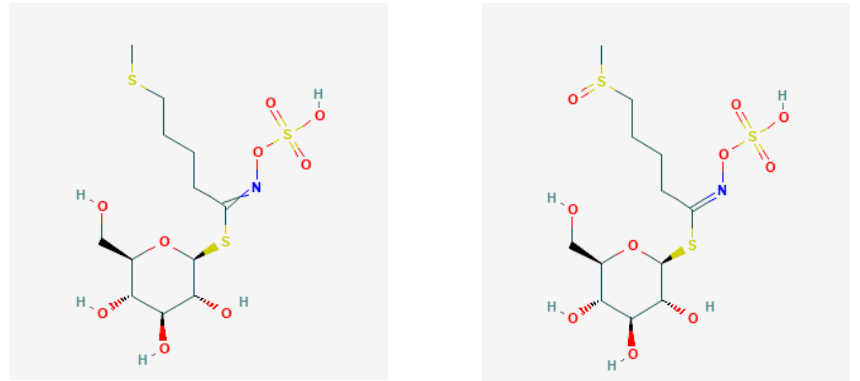
4 of 20 Figure 2. Chemical structures of glucocapparin (PubChem Identifier: CID 5281133; https://pub- chem.ncbi.nlm.nih.gov/compound/21600408) and sinigrin (PubChem Identifier CID 23682211;